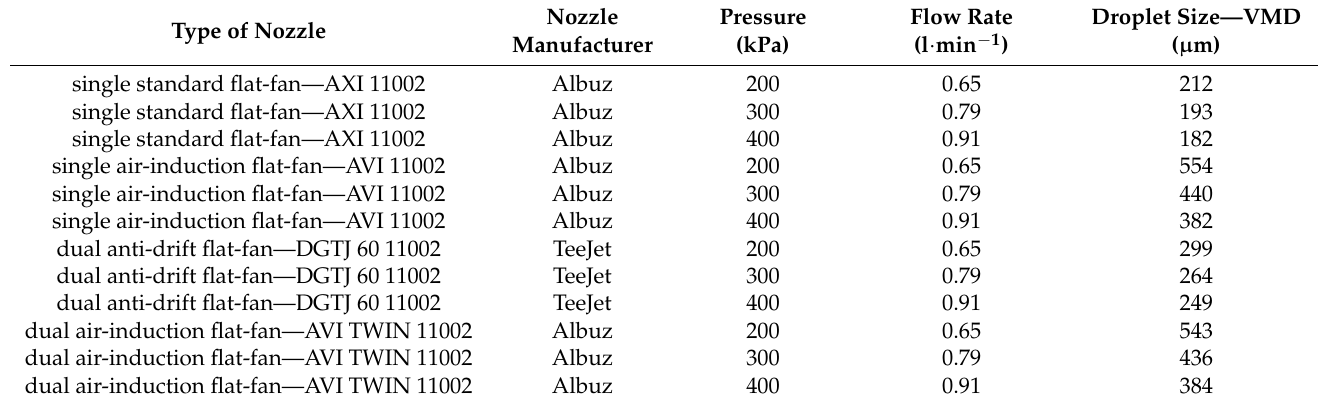
Table 1. The droplet size for each combination of the type of nozzle and the pressure.